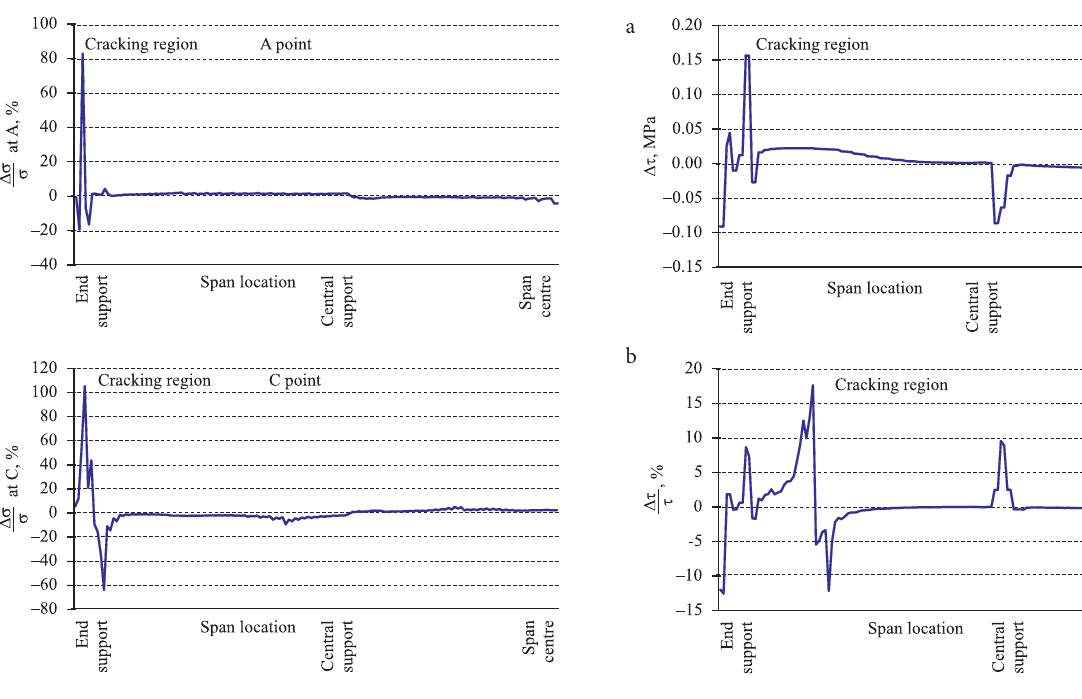
Fig. 14. of web under dead load after bottom slab cracking Fig. 15. Shear stress of web: a – ∆ τ of web after bottom slab cracking; b – of web after bottom slab